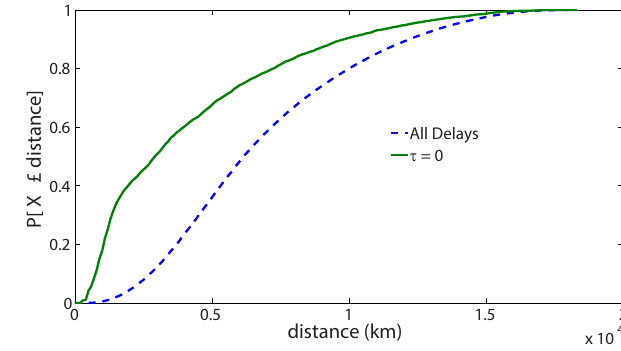
Figure 9. Reanalysis of the ± 200-day lag pairs from Fig. 1 using Eq. (14). This was done for 10% of the ± 200-day lag links in the network, and 5% of the 200-day lag points for all pairs, which were randomly chosen. These are compared to a uniform distribution for reference. Both of these plots show a peak about zero, which is more physically reasonable then a lag of ± 200 days, and therefore more likely to be the correct time delay. For these we used a value of (cid:127) = 441 to analyse the peaks about τ = ± 200. The inset shows a reanalysis of all links using Eq. (14). We can see that there is no bias in that figure, as well as a larger peak about zero than in Fig. 1. Here a value of (cid:127) = 365 was used for comparison with the original results.